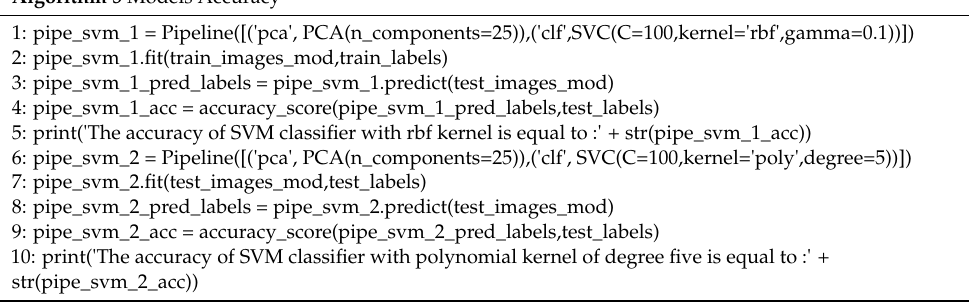
Algorithm 5 Models